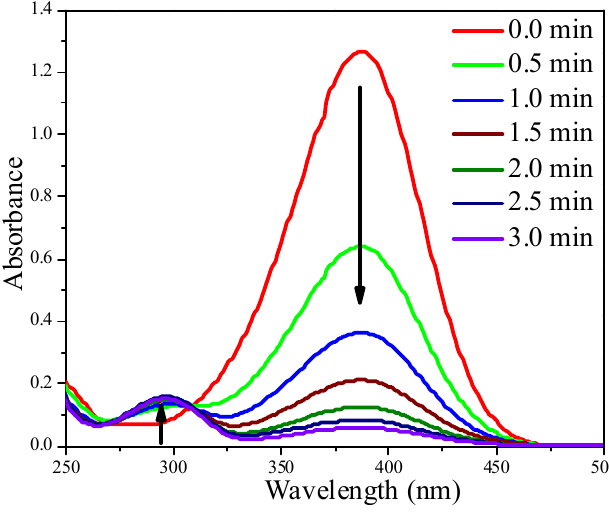
Figure 7. The time course of UV-Vis spectra of the 4-NP reduction system using 1.0 mL 5.7 nm Au NP colloid solution containing 0.10 mg Au NPs.